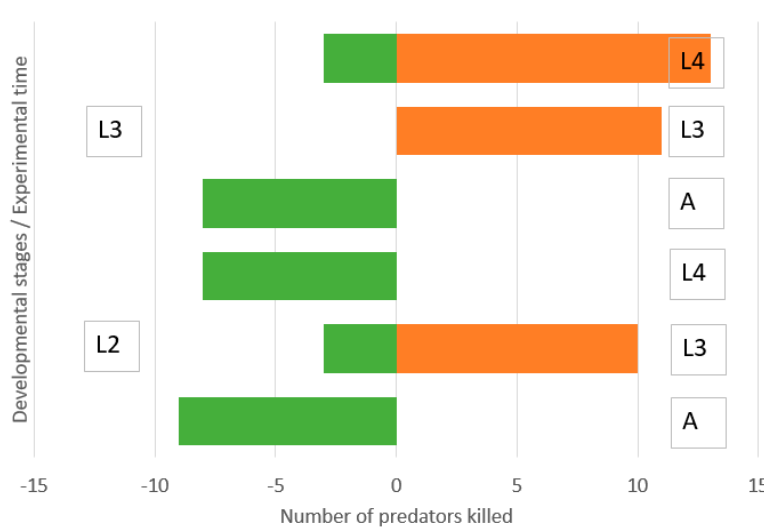
Figure 5. Direction of intraguild predation between Chrysoperla carnea, second (L2) and third instar larvae (L3), and Hippodamia variegata adults (A), third instar larvae (L3) and fourth instar larvae (L4) in microcosm. Numbers of predators killed of initial N = 120 during three days.